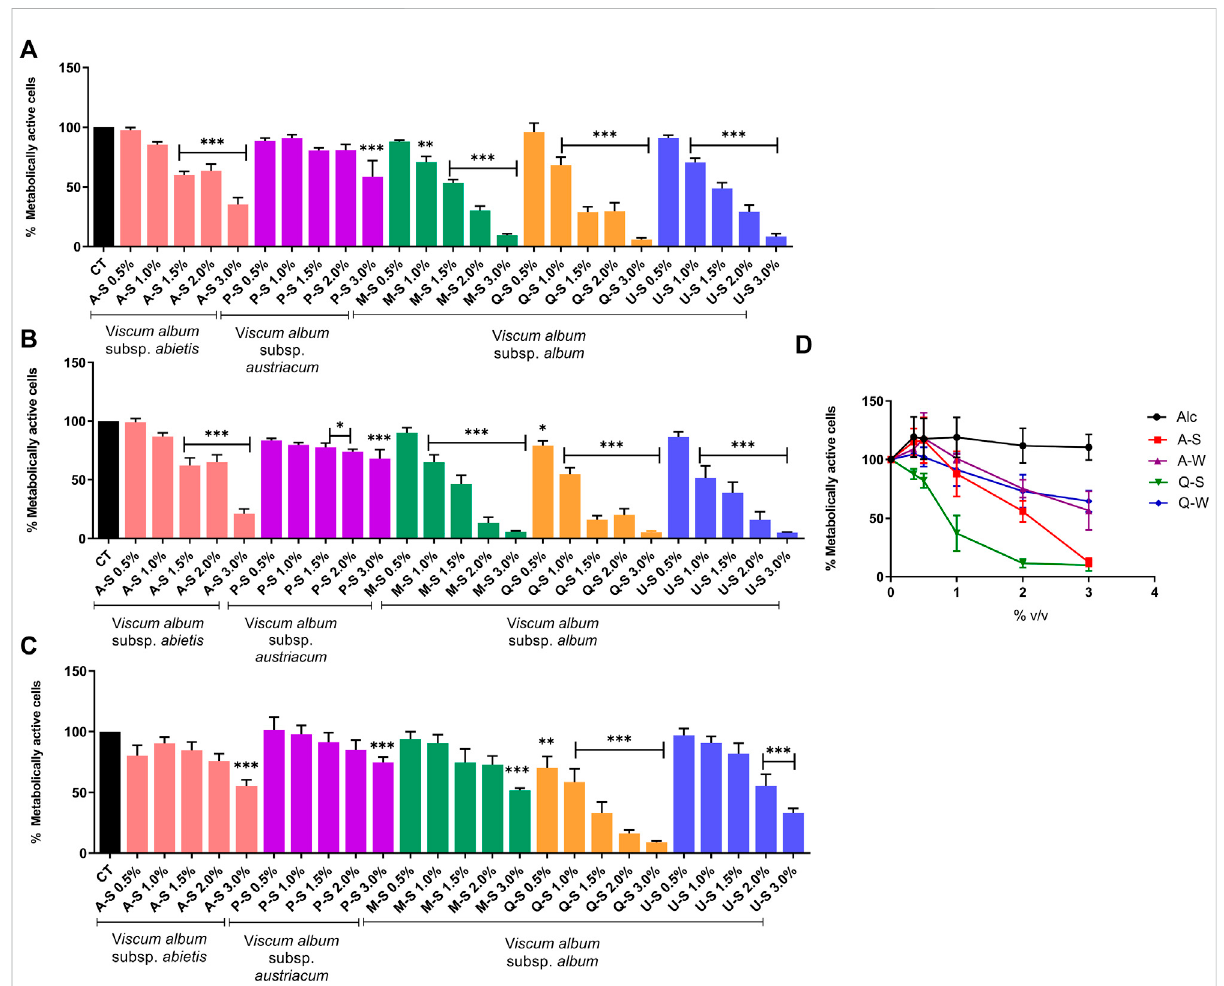
FIGURE 2 Dose-response effect of V. album mother tinctures on MDA-MB-231 and HaCaT cell lines proliferation assessed by MTT. (A) MDA-MB- 231 summer-dose effects after 24 h of treatment with MTs. (B) MDA-MB-231 summer-dose response curve after 48 h of treatment with MTs (C) HaCaT summer-dose response effects after 24 h of treatment with MTs. (D) MDA-MB-231 dose response curves after 72 h of treatment with summerandwinterMTs(A-S/W;Q-S/W).The fi nalconcentrationsvariedfrom0.5to3.0%v/v.Theresultsarecalculatedasthemean±standard error from three independent experiments, done in triplicate, in relation to control groups (untreated and treated with ethanol). * p < 0.05; ** p < 0.001;*** p < 0.0001obtainedwithone-wayANOVA/Dunnet ’ sposthoctest.Legendsymbols:(CT)controluntreatedcells;(Alc)cellsincubatedwith ethanol solvent; V. album subsp. album growing on Malus domestica (M-S/W), Quercus petraea (Q-S/W) and Ulmus carpinifolia (U-S/W); V. album subsp. abietis growing on Abies alba (A-S/W); and V. album subsp. austriacum growing on Pinus sylvestris (P-S/W). Samples were harvested in summer (S) and winter (W)